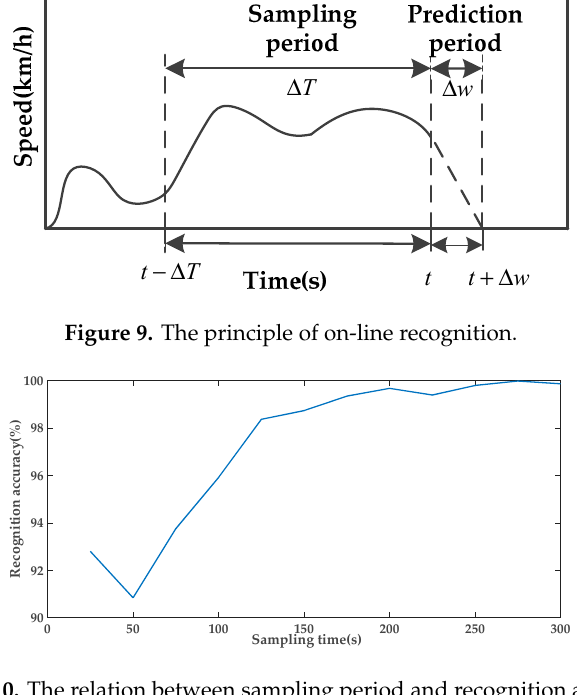
Figure 10. The relation between sampling period and recognition accuracy.